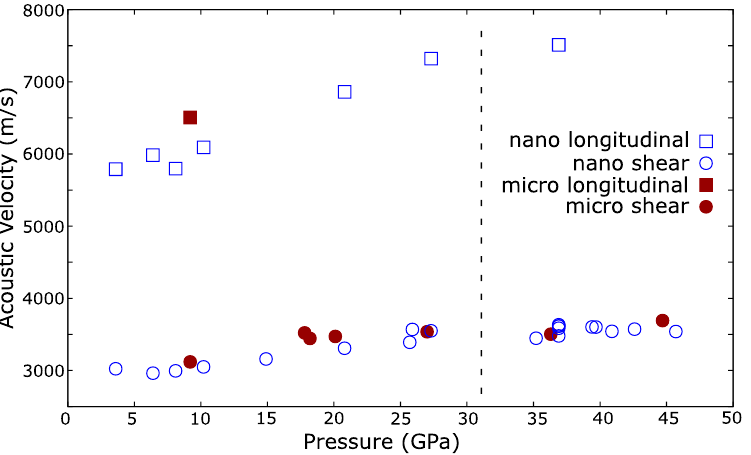
Figure 4. The evolution of the sound velocities of cerium dioxide micro- and nanopowders with pressure. Open symbols are nanopowders, closed symbols are micropowders. Squares are longitudi- nal mode velocities, circles are transverse. Acoustic velocity is not significantly affected by particle size. Vertical dashed line indicates the nominal transition pressure from the Fm ¯ 3 m phase to Pnam . Uncertainties are of similar size to plotting points: 40 ms − 1 for shear and 60 ms − 1 for longitudinal sound